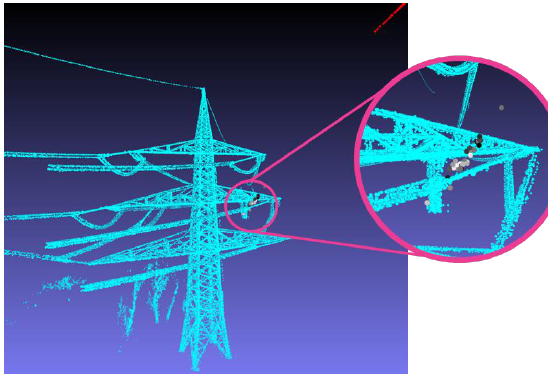
Figure 10. Sample of partial discharges clustered in